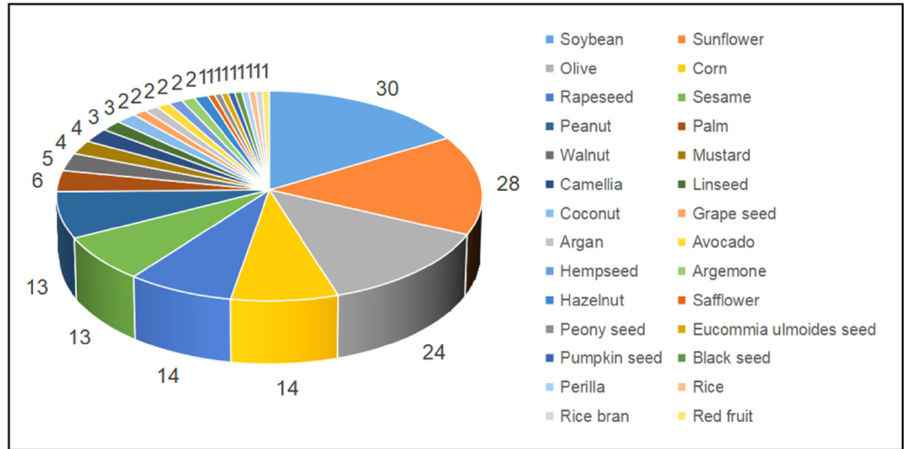
Figure 4. The number of studies using different edible oils for preparing edible oil blends in liter- ature from 2002–2022.